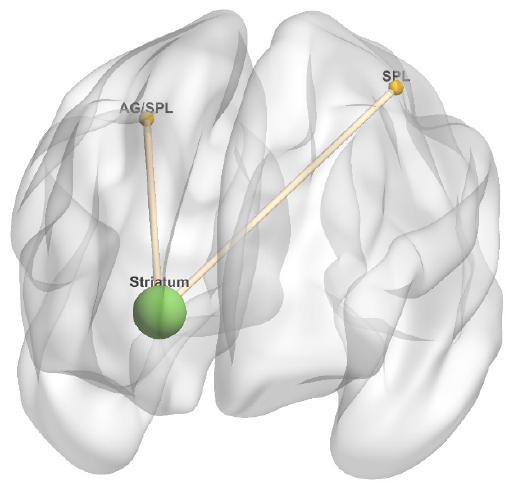
Table 7. Task-independent (residual) fatigue-related functional connectivity with the striatum as seed. Striatum Seed Location X Y Z Voxels Z Stat Increased Task-independent Residual Connectivity in 2-back Condition MS Superior Parietal Lobule − 30.7 − 80.4 58 4.73 Angular Gyrus / Superior Parietal Lobule 41.5 − 80.4 42 4.58 “X”, “Y”, and “Z” denote the three-dimensional peak coordinates of each significant clusters. Positive “X” values represent the right hemisphere, and negative “X” values represent the left hemisphere. “Voxels” denote the number of voxels in each cluster. “Z Stat” reflects the extent of functional connectivity between the seed region and the brain region in each row; positive values represent increased functional connectivity in the 2-back condition, and negative values represent increased functional connectivity in the 0-back condition. Abbreviations: MS, multiple sclerosis. HC, healthy control.